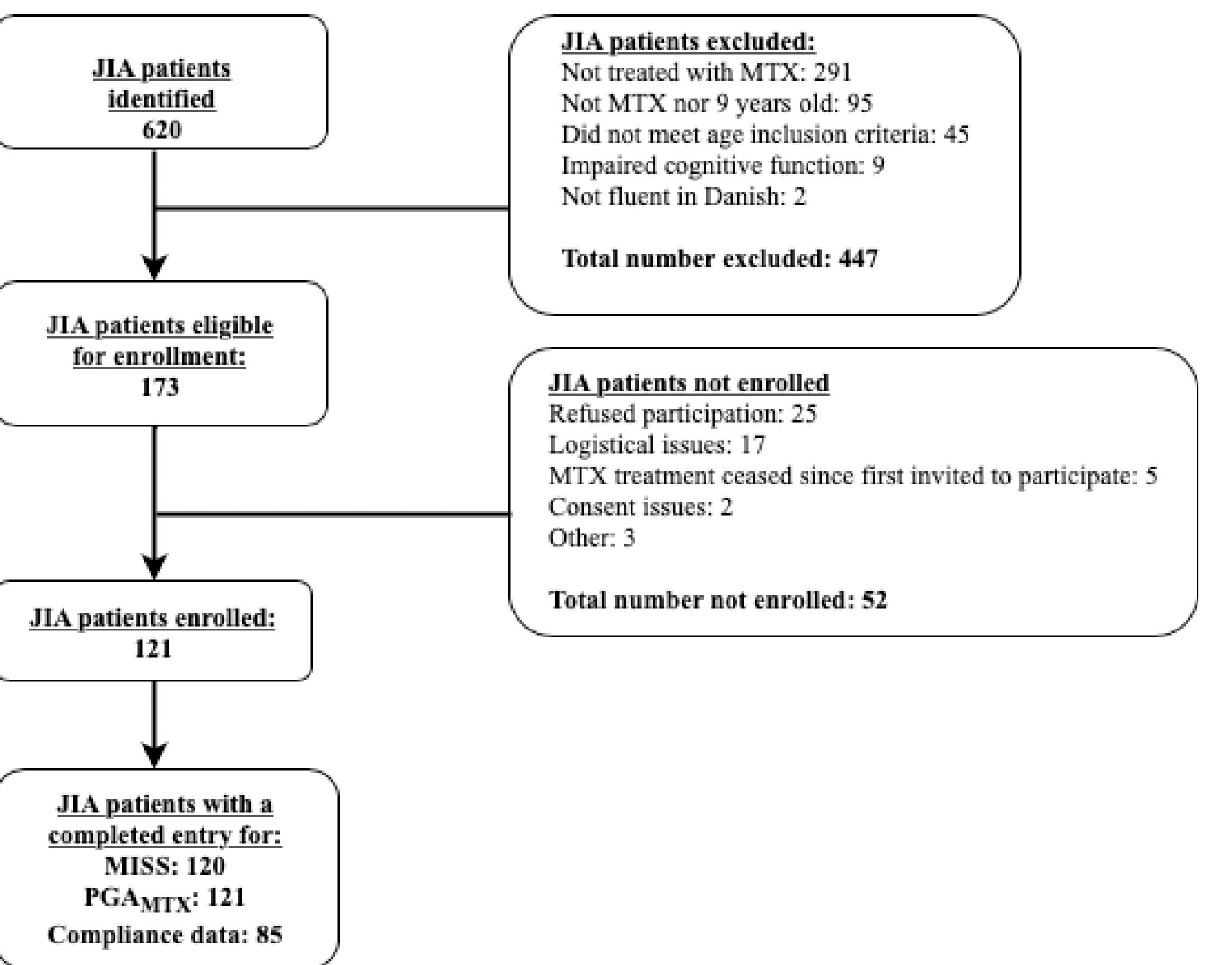
Fig 1. The juvenile idiopathic arthritis study population. Flowchart showing the enrolment and exclusion of patients within the juvenile idiopathic arthritis (JIA) study population. MTX; low-dose methotrexate. MISS; Methotrexate intolerance severity score. PGA mtx ; Physician’s global assessment of MTX